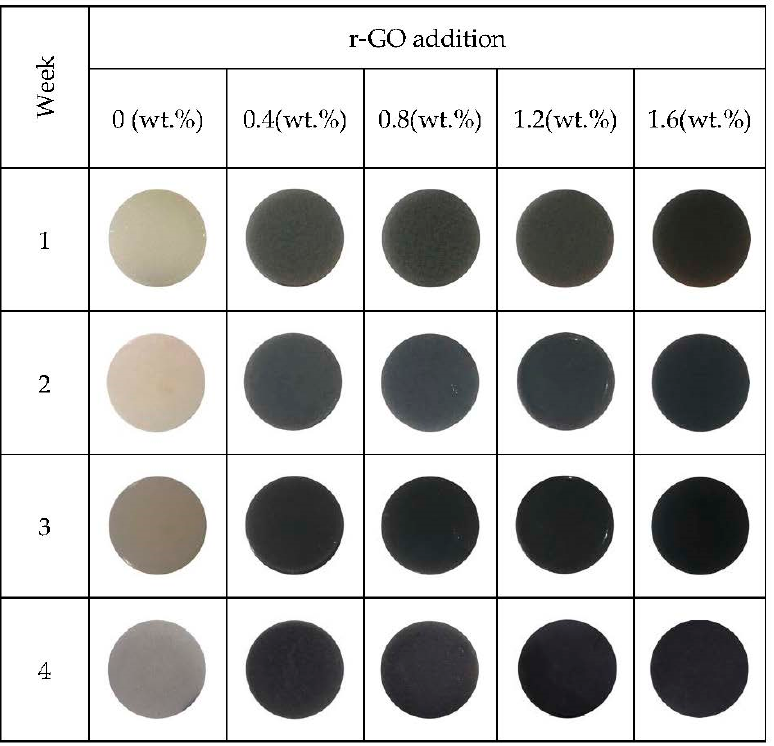
Figure 5. Visual observation of Alginate/PVA/r-GO for four weeks. Table 1. Degradation ratio of hydrogel composite Alginate/PVA/r-GO *.